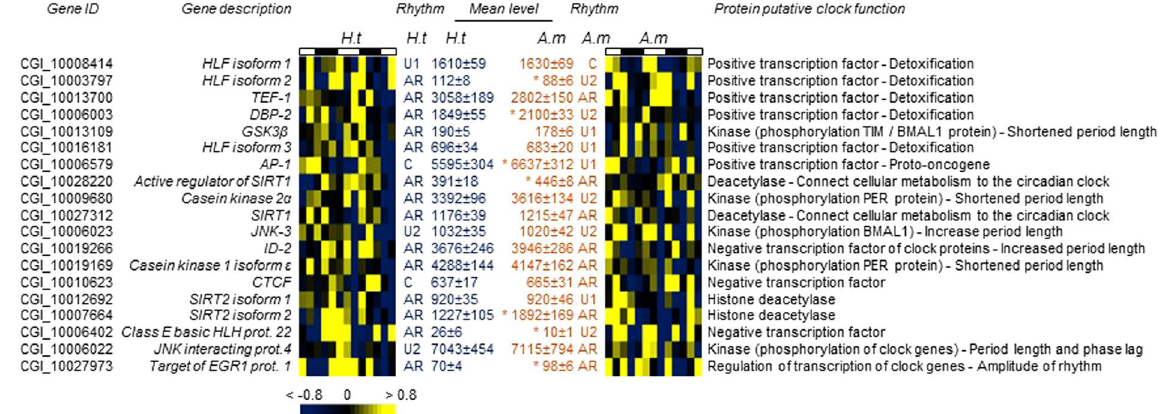
Figure 4. Ultradian oscillations observed in clock subsystem elements. Heat map expression of orthologous genes implicated in the clock network in mammals and insects, organized by phase of oscillation in H.t . “Rhythms”, results of cycling analysis (circadian, U1, U2). “Mean level”, the mean level of expression (mean ± SE). * Significant difference at p < 0.05.